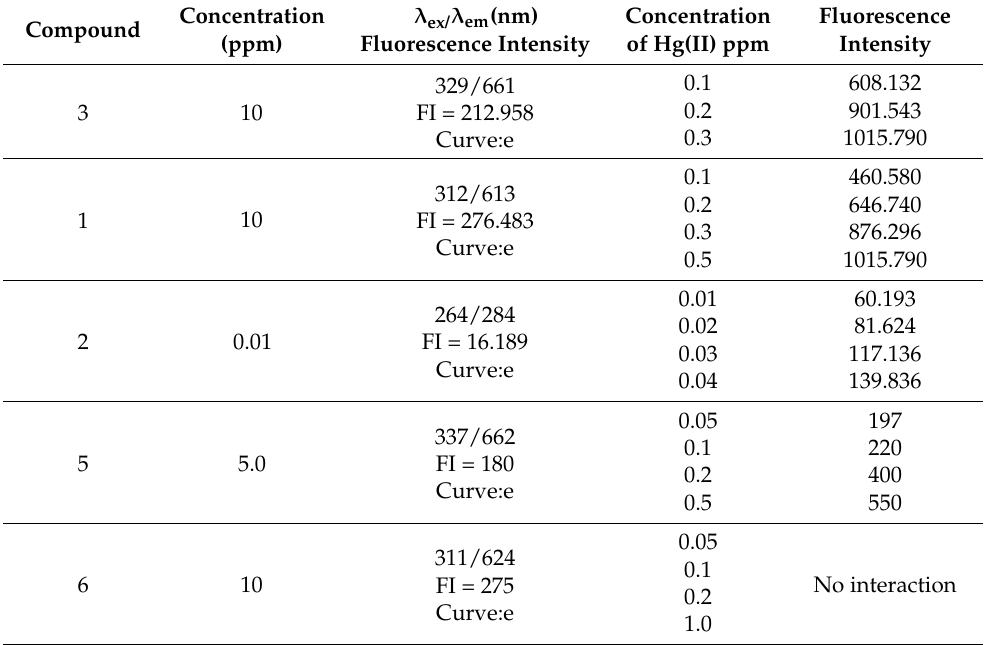
Table 6. Hg(II) sensing studies of compounds 1 – 3 , 5 and 6 , FI in the Table stands for fluorescence intensity.